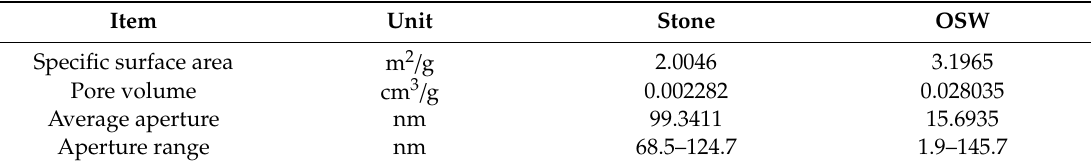
Table 7. BET test results of stone and